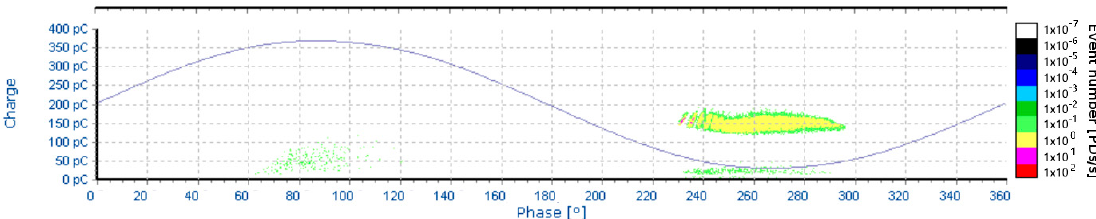
Figure 16. Pattern diagram for 7 kV, needle-plane arrangement.